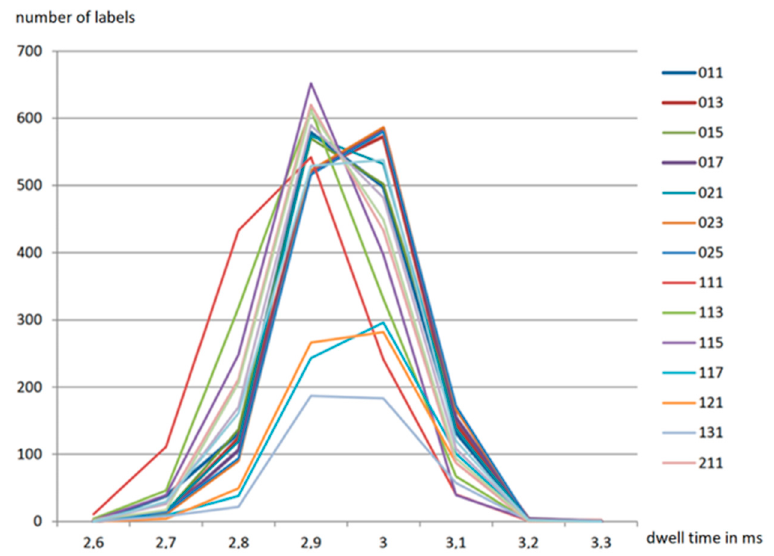
Figure 14. 1-Channel Measurement for the flap load relief function.